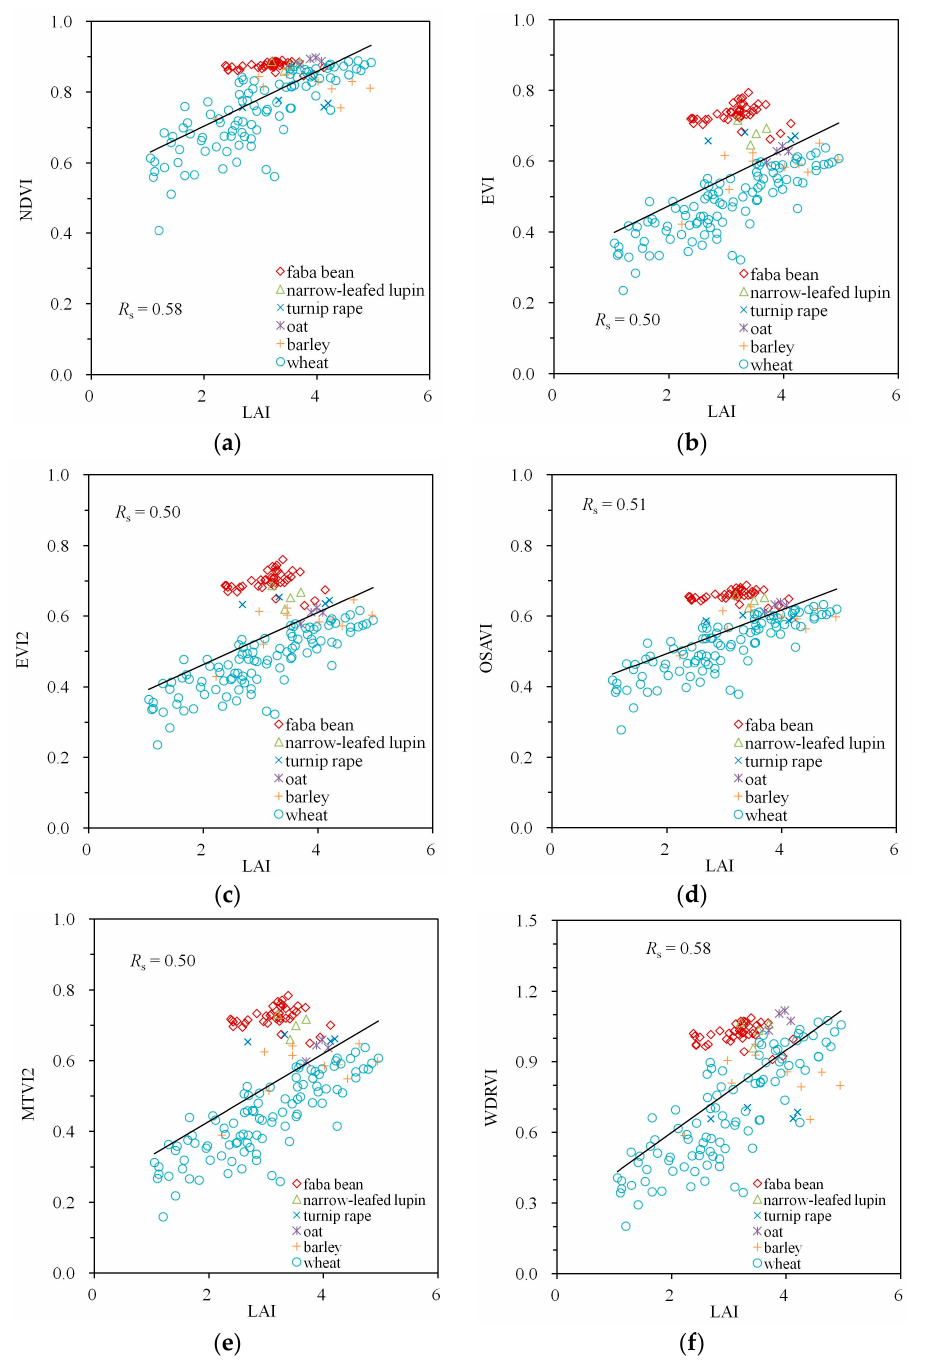
Figure 4. Empirical relationships between LAI and VIs calculated from Spearman’s correlation coefficient R s : ( a ) NDVI, ( b ) EVI, ( c ) EVI2, ( d ) OSAVI, ( e ) MTVI2, ( f ) WDRVI. A simple trend line calculated from linear regression was added to visualize the trend of the variation.